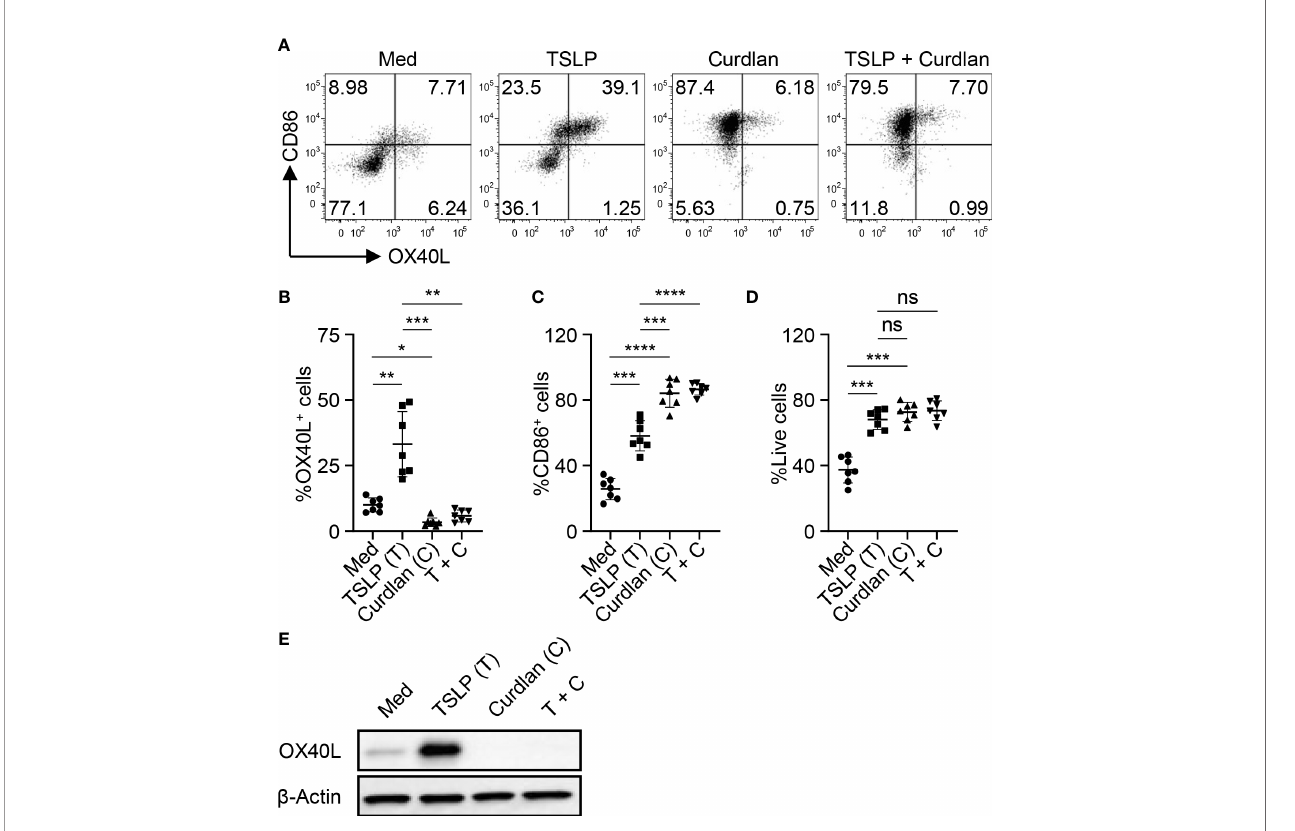
FIGURE 1 | Dectin-1 Activation Suppresses TSLP-Induced OX40L Expression by mDCs and Th2 Cell Priming. (A – C) Sorted mDCs were incubated with medium (Med), TSLP and/or curdlan for 48h before surface staining of CD86 and OX40L. Live singlets were gated for analysis. Representative FACS data (A) and summarized data (B, C) of OX40L and CD86 expression from different donors (n = 7) are shown. (D) After 48h culture of sorted mDCs treated as in (A) , frequency of live cells in total cells was assessed by Live/Dead Aqua staining. Summarized data from different donors (n = 7) is shown. (E) Whole cell lysates of mDCs treated as in (A) were used for immunoblotting of OX40L. The data shown is representative of three independent experiments. Data in (B, C) are represented as mean ± SD. Signi fi cance was determined using one-way ANOVA with Tukey multiple comparisons test for (B – D) . * p < 0.05, ** p < 0.01, *** p < 0.001, **** p < 0.0001 for the comparison between groups. ns, not signi fi